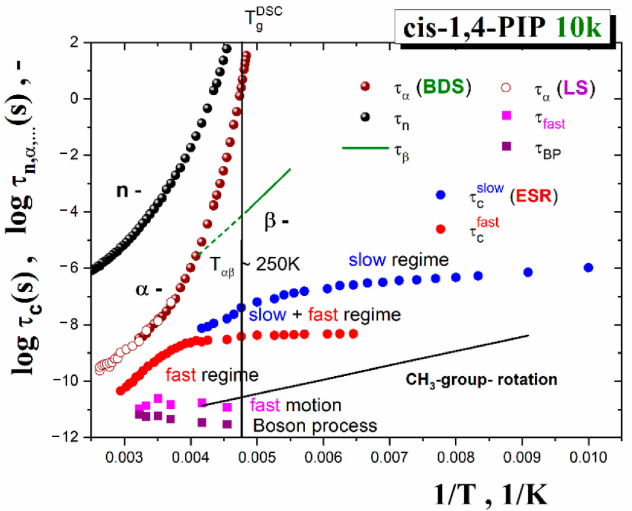
Figure 16. Relaxation map of cis -1,4-PIP10k sample consisting of BDS, light scattering (LS) and neutron scattering (NS) time scales together with those for the spin probe TEMPO correlation times in cis -1,4-PIP10k, τ c , obtained in the temperature range 100 K up to 400 K. Dynamic data include the chain relaxation time, τ n , from BDS [50], the segmental relaxation, τ α , from BDS [50] and LS and the secondary β relaxation, τ β , in 1,4-PIP500k over 180 K–205 K from BDS [74], the fast motion relaxation, τ fast , and boson peak, τ boson , from LS as well as CH 3 -jump rotation over 110–240 K from NS